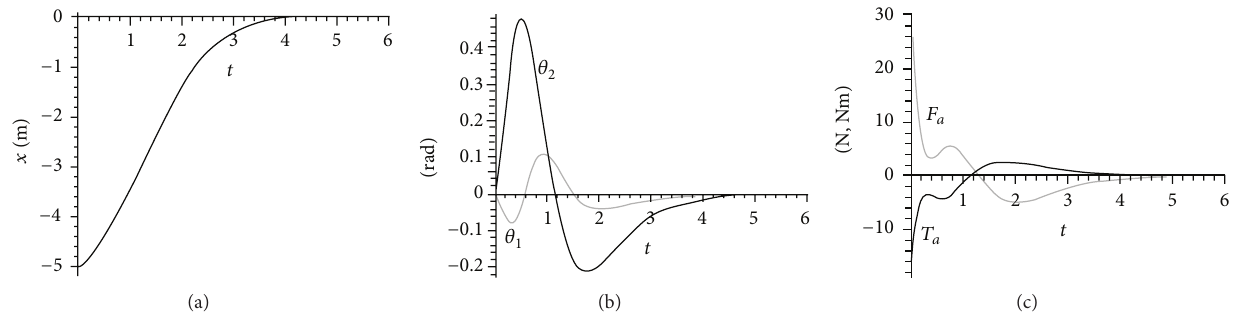
Figure 6: (a) Cart trajectory, (b) swing angles, and (c) force/torque for the modified gantry crane.